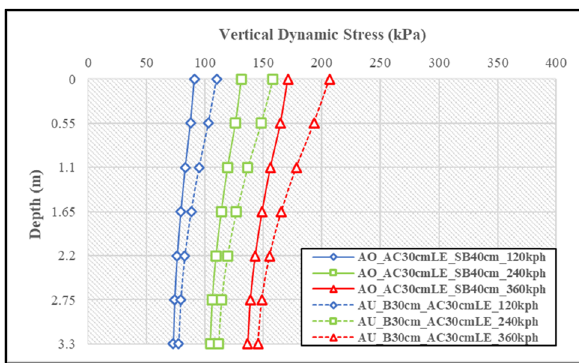
Figure 13: Vertical compressive stress curve in subgrade layer of asphaltic underlayment track and asphaltic overlayment track with 30 cm of AC layer under train speed of 120, 240, and 360